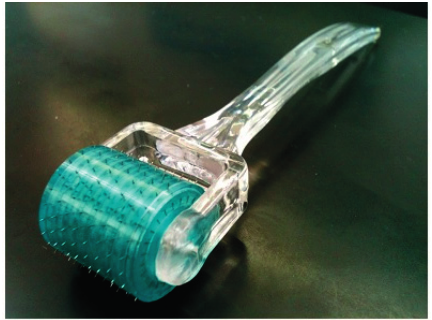
Figure 1. Stainless steel microneedle roller, density of 192 microneedles and 500 μ m in length per